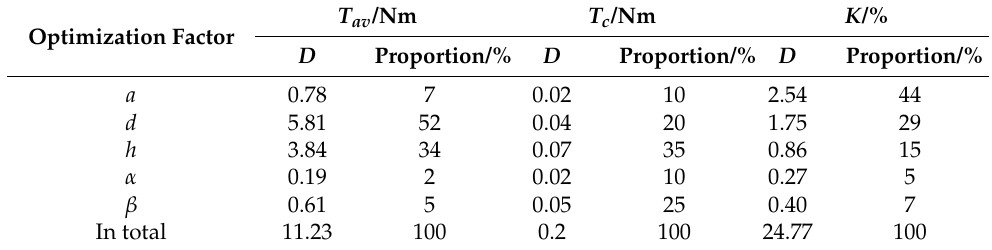
Table 10. Performance comparison of three